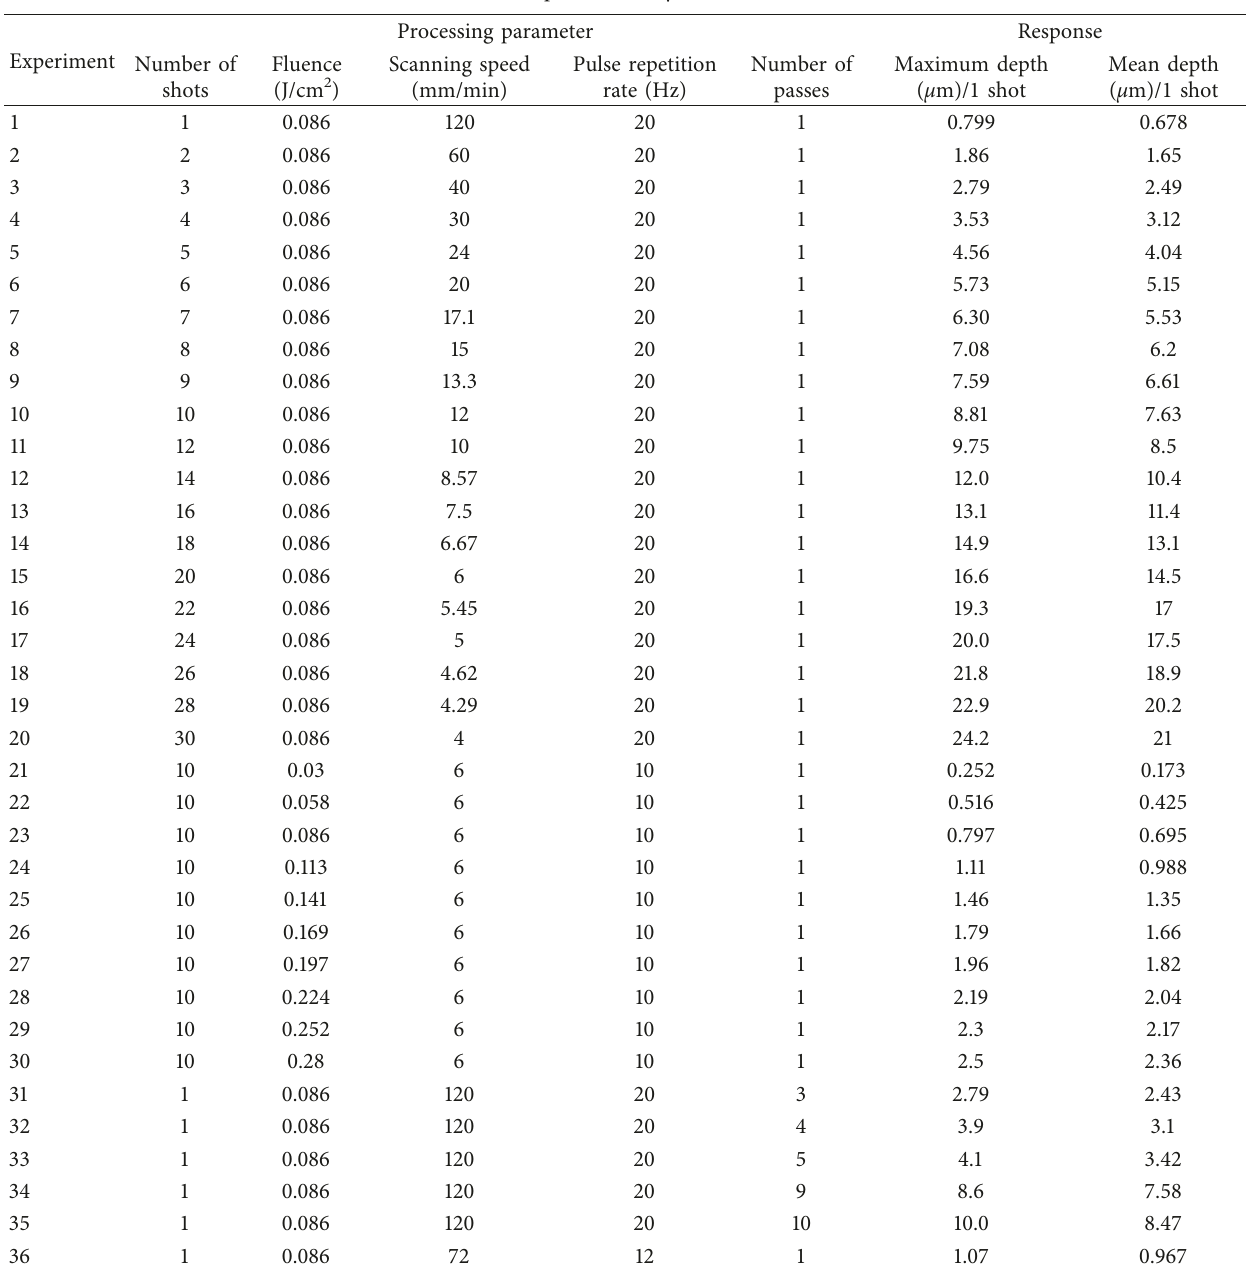
Table 1: Experimental layout and